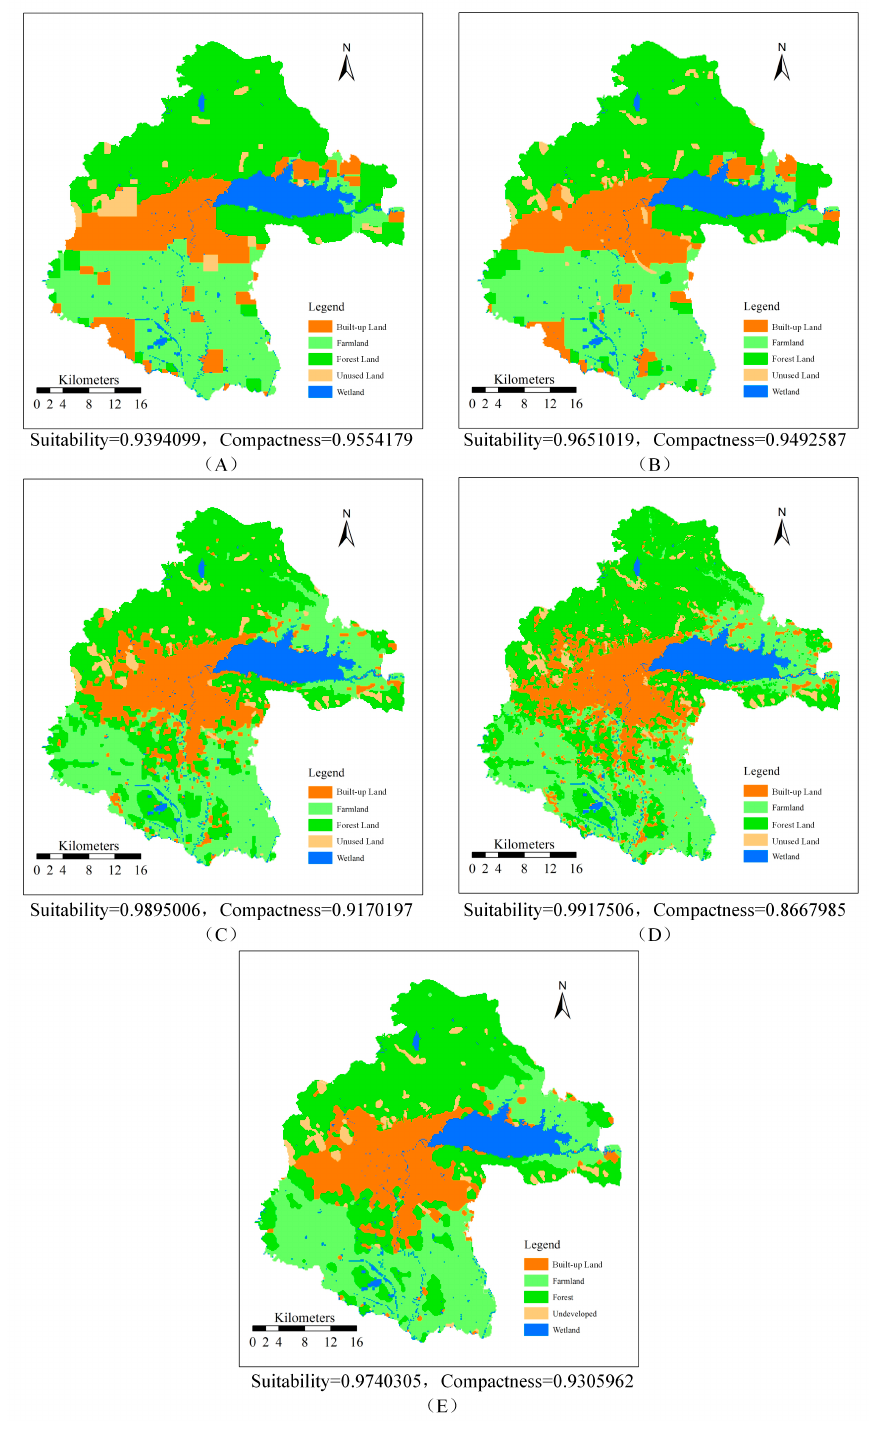
Figure 13. The spatial allocation of the five labelled solutions in Figure 12. (A) The spatial allocation of solution A; (B) The spatial allocation of solution B; (C) The spatial allocation of solution C; (D) The spatial allocation of solution D; (E) The spatial allocation of solution E.